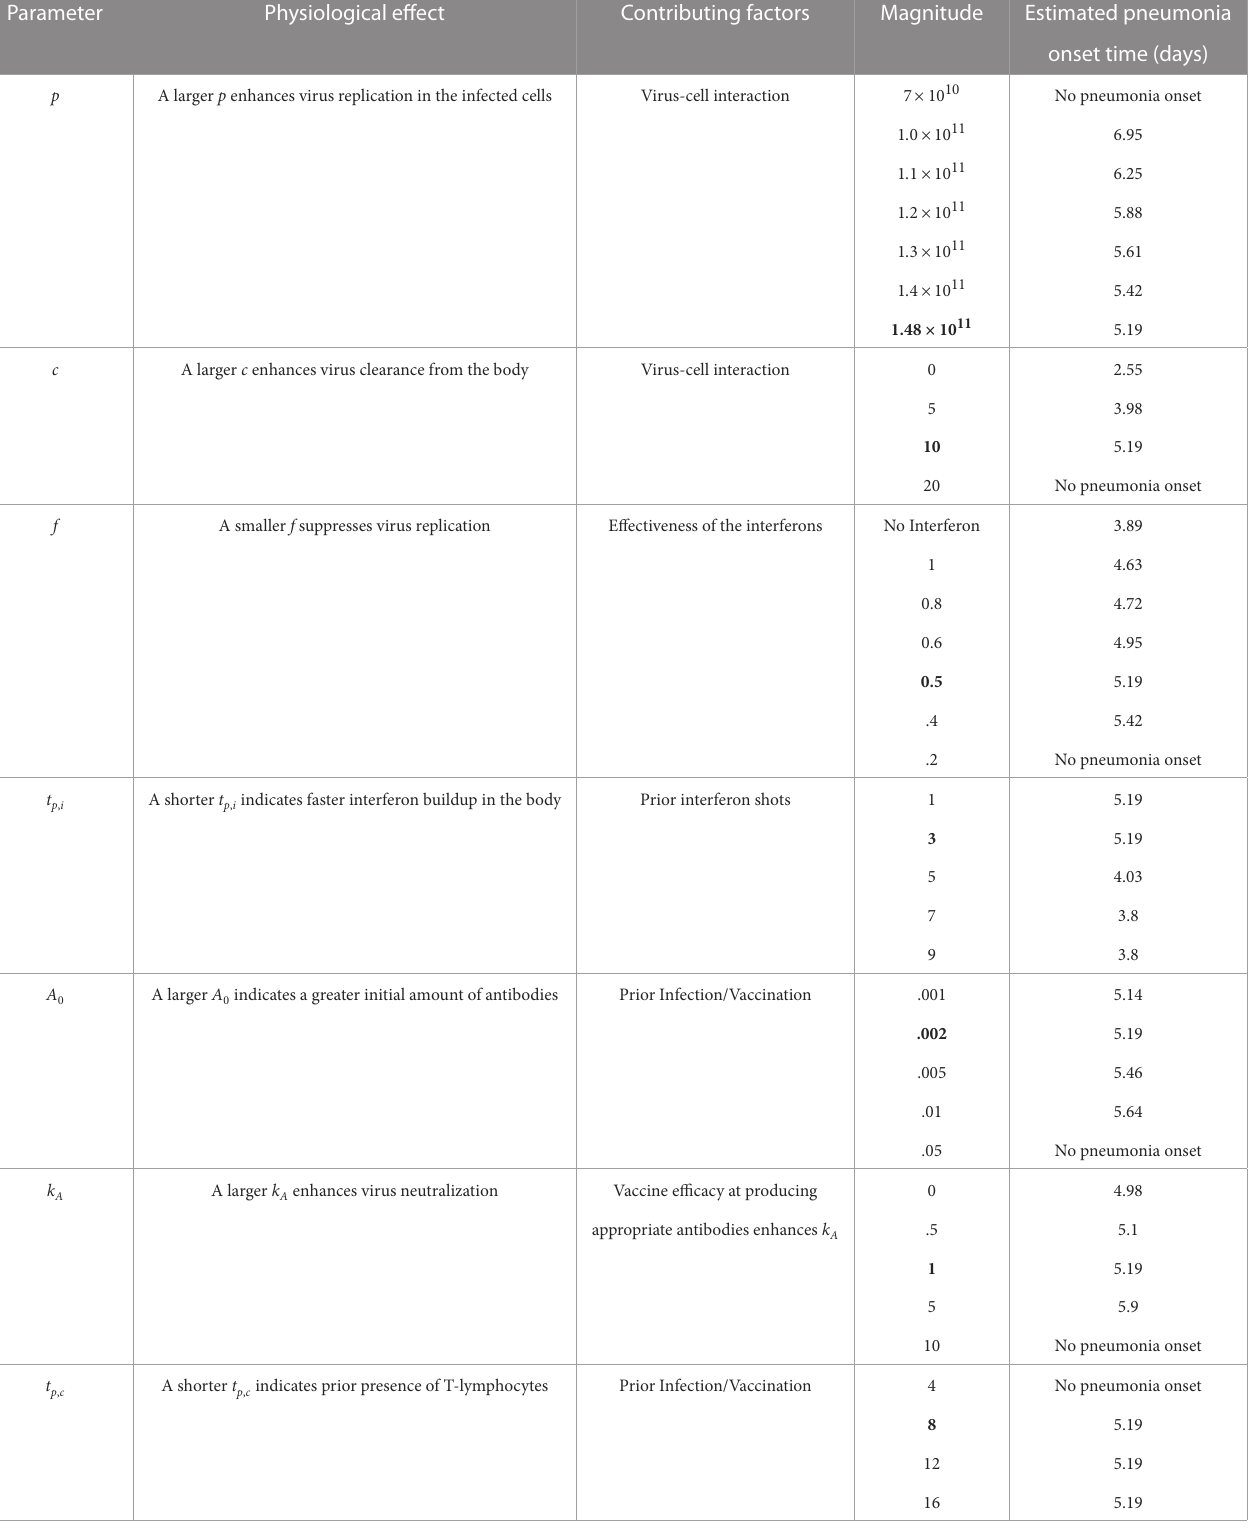
TABLE3 VariationinestimatedtimerequiredforonsetofSARS-CoV-2pneumoniawithchangeinvariousdimensionalinfectionparameters.